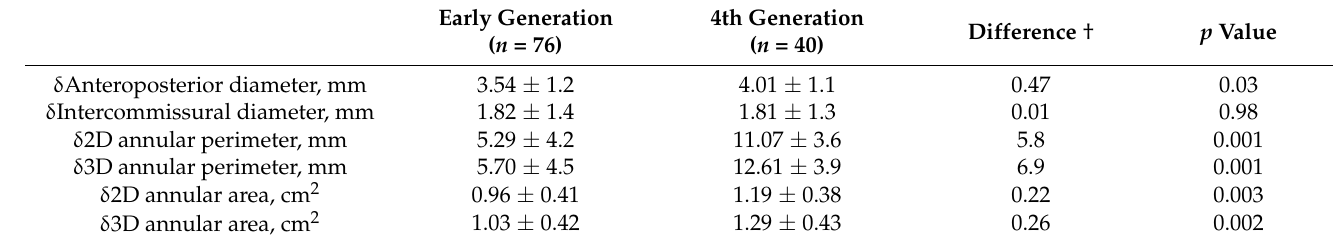
Table 4. Absolute reductions in mitral valve anatomic parameters according to device generation (1st, 2nd, and 3rd generation vs. 4th